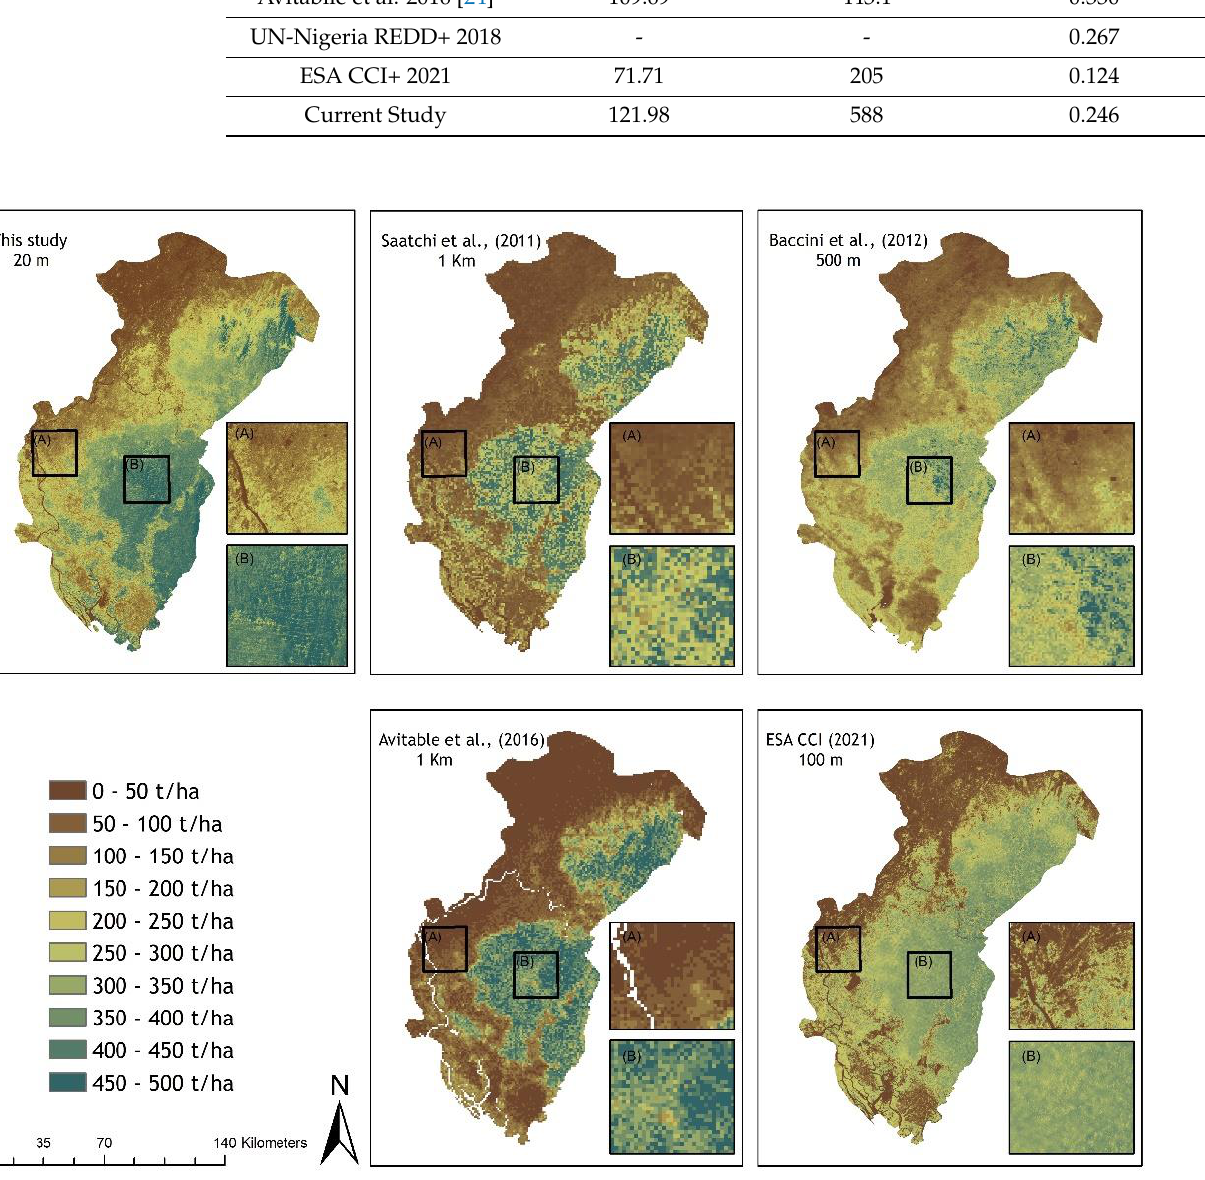
Figure 6. AGB products over the Cross River State of this current study and the Saatchi [22], Baccini [23], ESA CCI+ [25] and Avitabile [24] at their respective resolutions. Zoom in areas showing an area of transition from high to lower AGB areas ( A ) and high biomass areas in the center of the state ( B ) are also given.Boxes A and B indicate locations and so have the same name for all five AGB